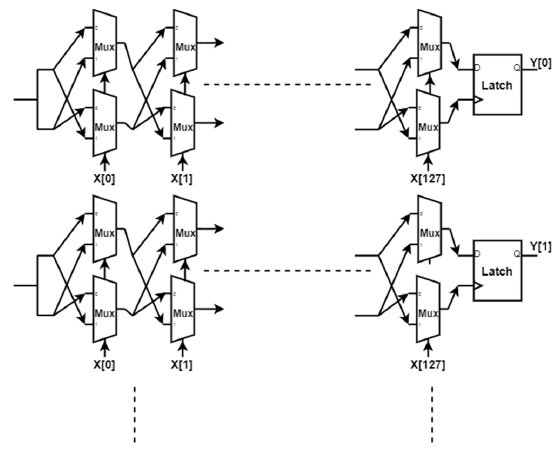
Figure 2. Model of 128-bit challenge Arbiter Physical Unclonable Function (PUF) circuit.